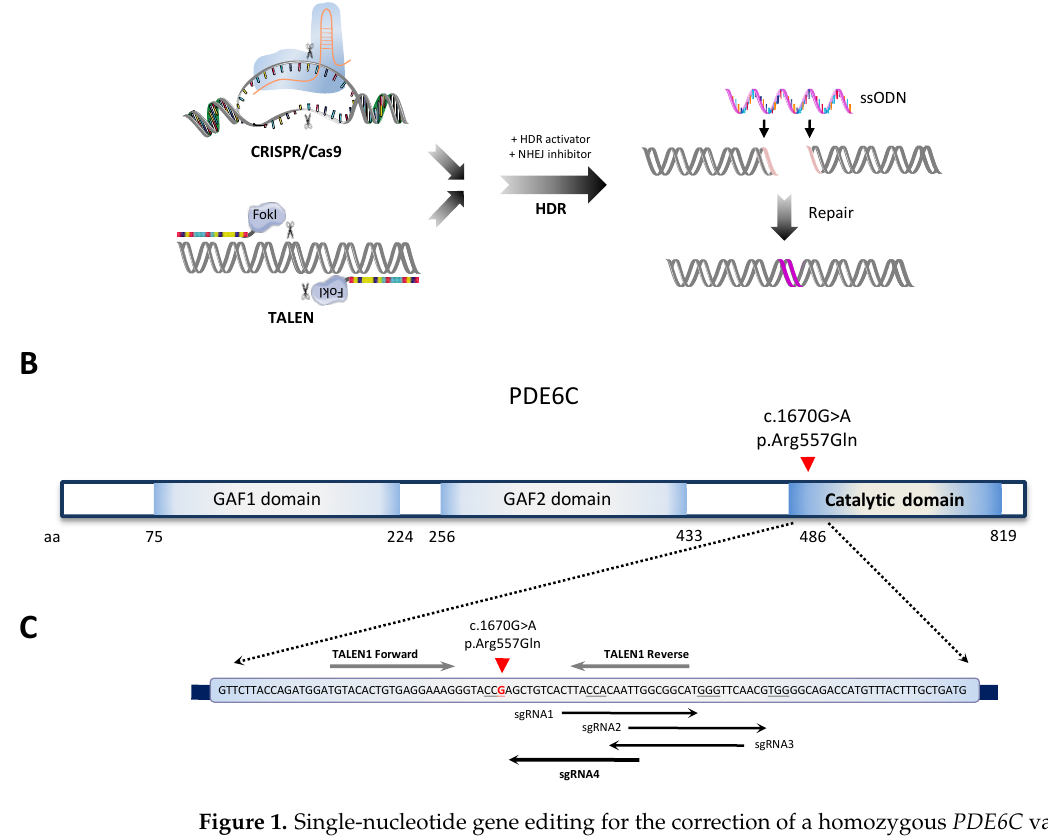
Figure 1. Single-nucleotide gene editing for the correction of a homozygous PDE6C variant causing achromatopsia. ( A ) Schematic of the assay followed for HDR-mediated gene editing by CRISPR/Cas9 and TALEN technologies. The figure was partially generated using Servier Medical Art, provided by Servier, licensed under a Creative Commons Attribution 3.0 unported license. ( B ) Representation of PDE6C protein domains. Homozygous patient’s mutation targeted for correction in exon 13 is depicted with a red arrowhead. ( C ) Schematic of the different TALEN and sgRNA guides designed for targeting the c.1670G>A mutation (nucleotide in red) on exon 13 of PDE6C . Arrows indicate sgRNA orientation. PAM sequences are underlined for each